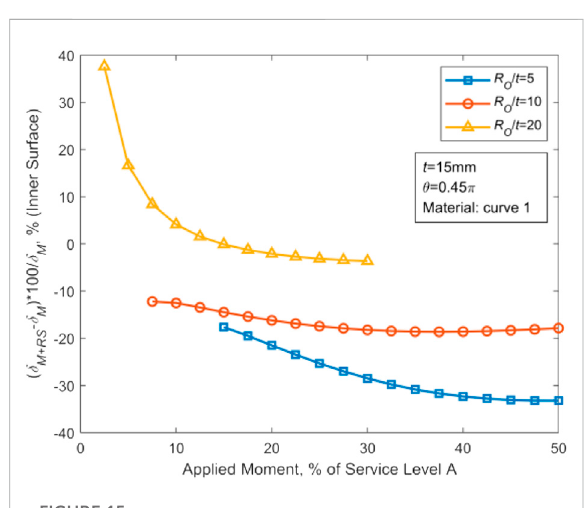
FIGURE 15 Variation of the inner wall Δ COD with the stress level